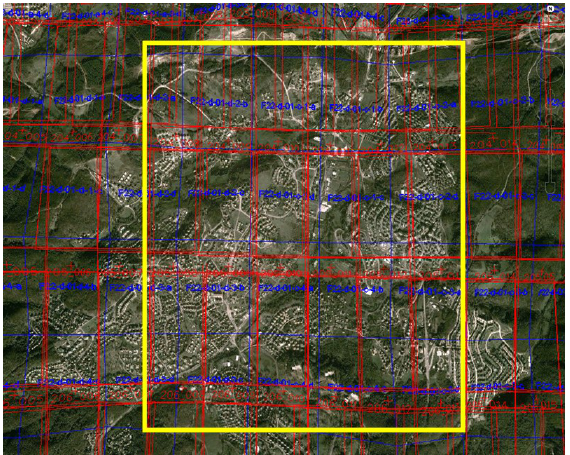
Figure 2. Study area in